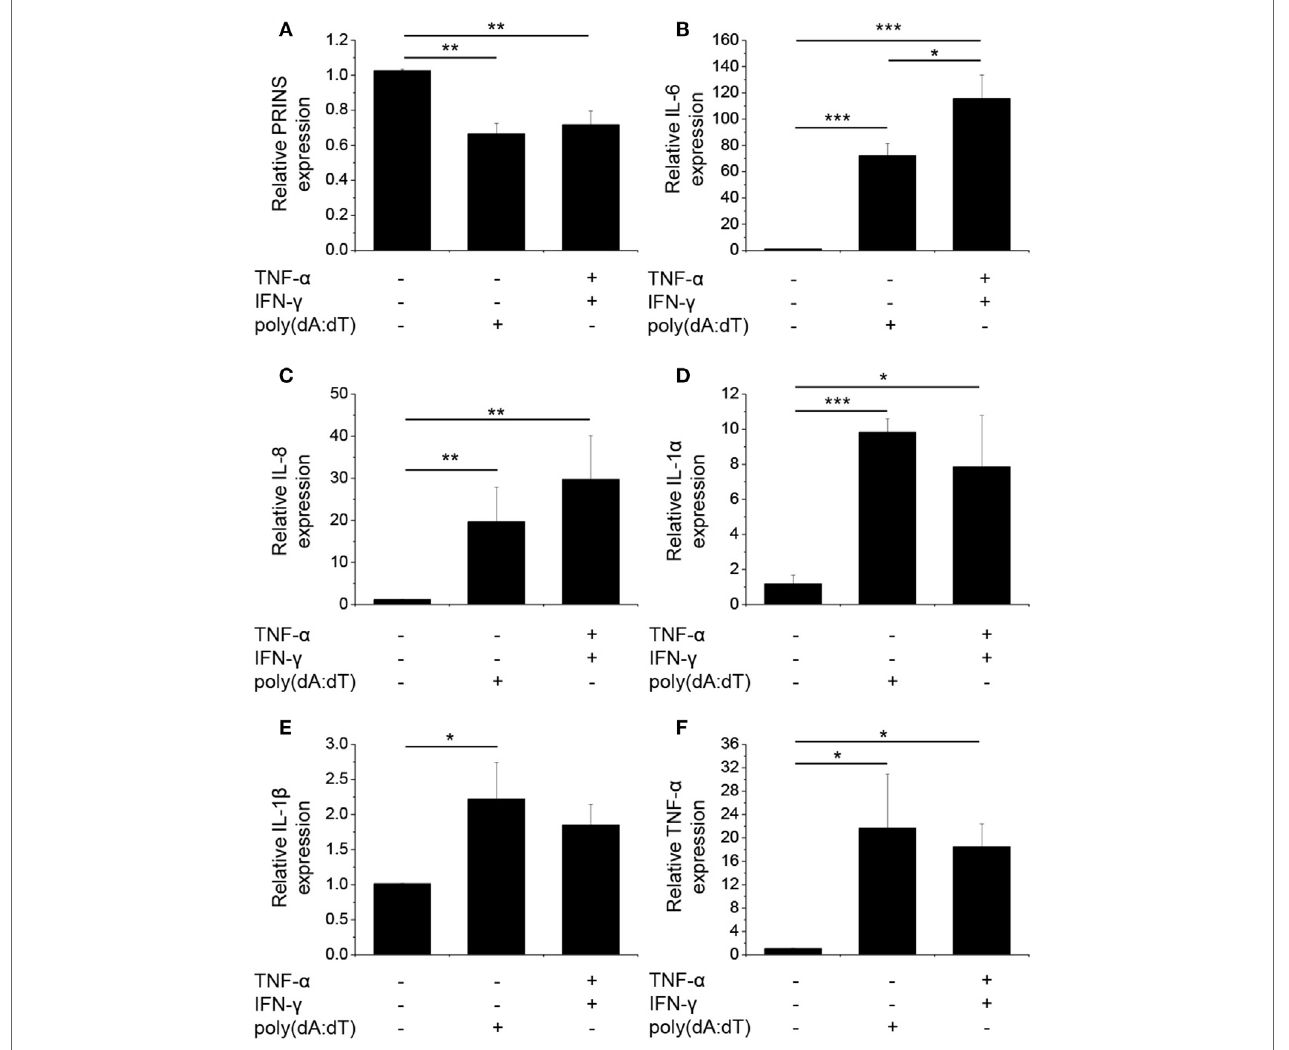
FigUre 1 | Poly(dA:dT) treatment decreased the expression of PRINS but induced the expression and secretion of cytokines. Normal human epidermal keratinocytes were transfected with poly(dA:dT) for 12 h with or without priming for 24 h with 5 ng/ml tumor necrosis factor- α (TNF)- α and interferon- γ (IFN- γ ). RNA expression was detected for PRINS (a) and cytokines interleukin-6 (IL-6) (B) , IL-8 (c) , IL-1 α (D) , IL-1 β (e) , TNF- α (F) by real-time RT-PCR. Data are presented as mean ± SE of five independent experiments (* p ≤ 0.05; ** p ≤ 0.01; *** p ≤